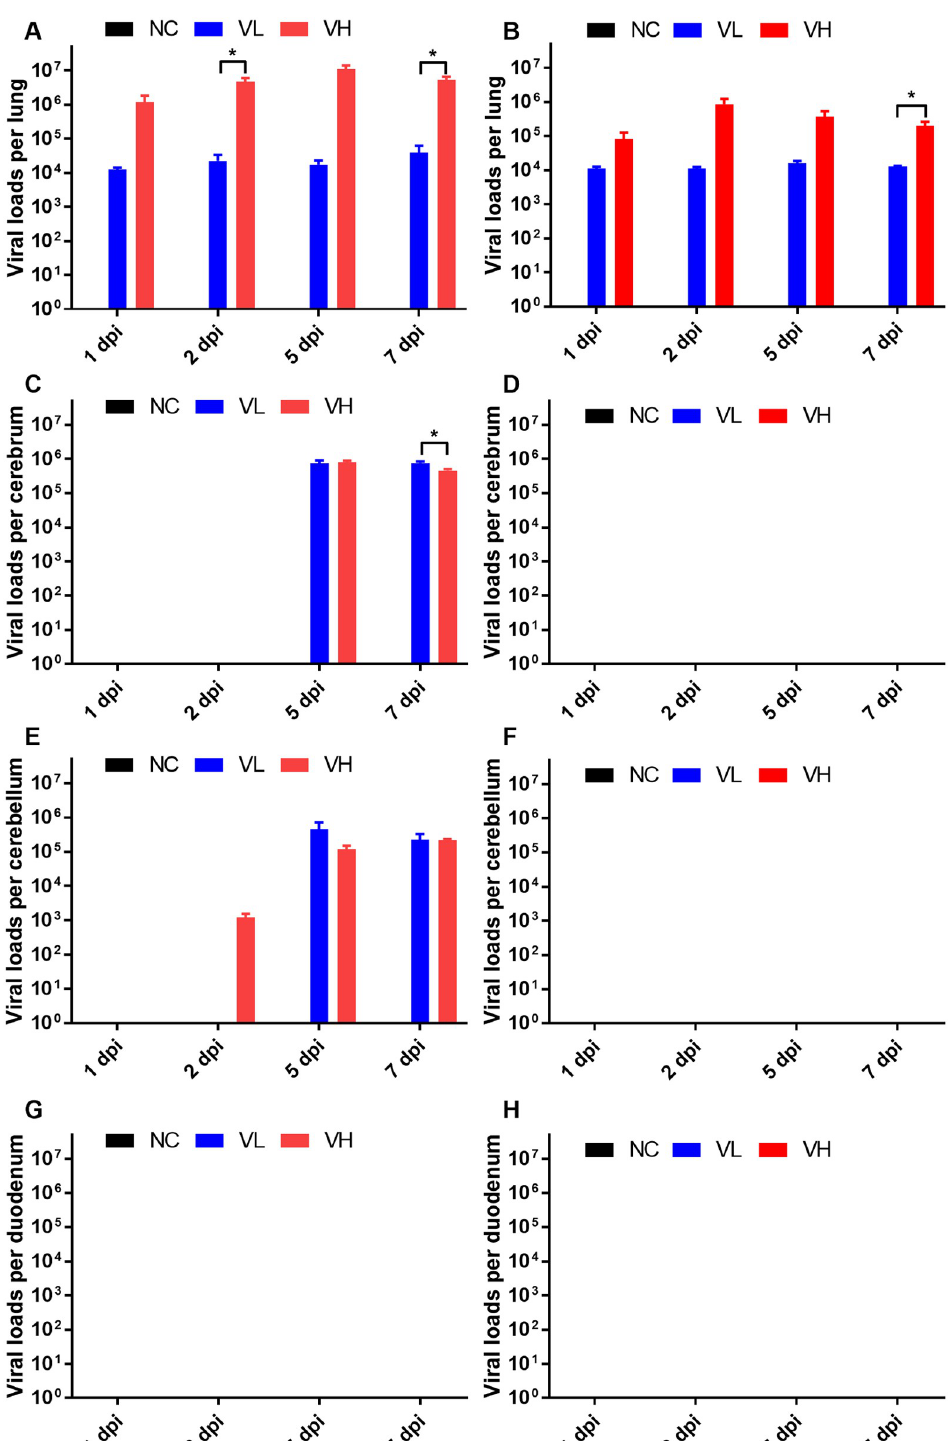
Fig 3. Kinetics of SARS-CoV-2 replication in organs of K18-hACE2 and CAG-hACE2 transgenic mice. Kinetics of SARS-CoV-2 replication in lungs of K18-hACE2 (A) and CAG-hACE2 (B); kinetics of SARS-CoV-2 replication in cerebrum of K18-hACE2 (C) and CAG-hACE2 (D); kinetics of SARS-CoV-2 replication in cerebellum of K18-hACE2 (E) and CAG-hACE2 (F); kinetics of SARS-CoV-2 replication in duodenum of K18-hACE2 (G) and CAG-hACE2 (H). Titers of SARS-CoV-2 were measured with quantitative PCR and expressed as TCID 50 SARS-CoV-2/organ. Data are